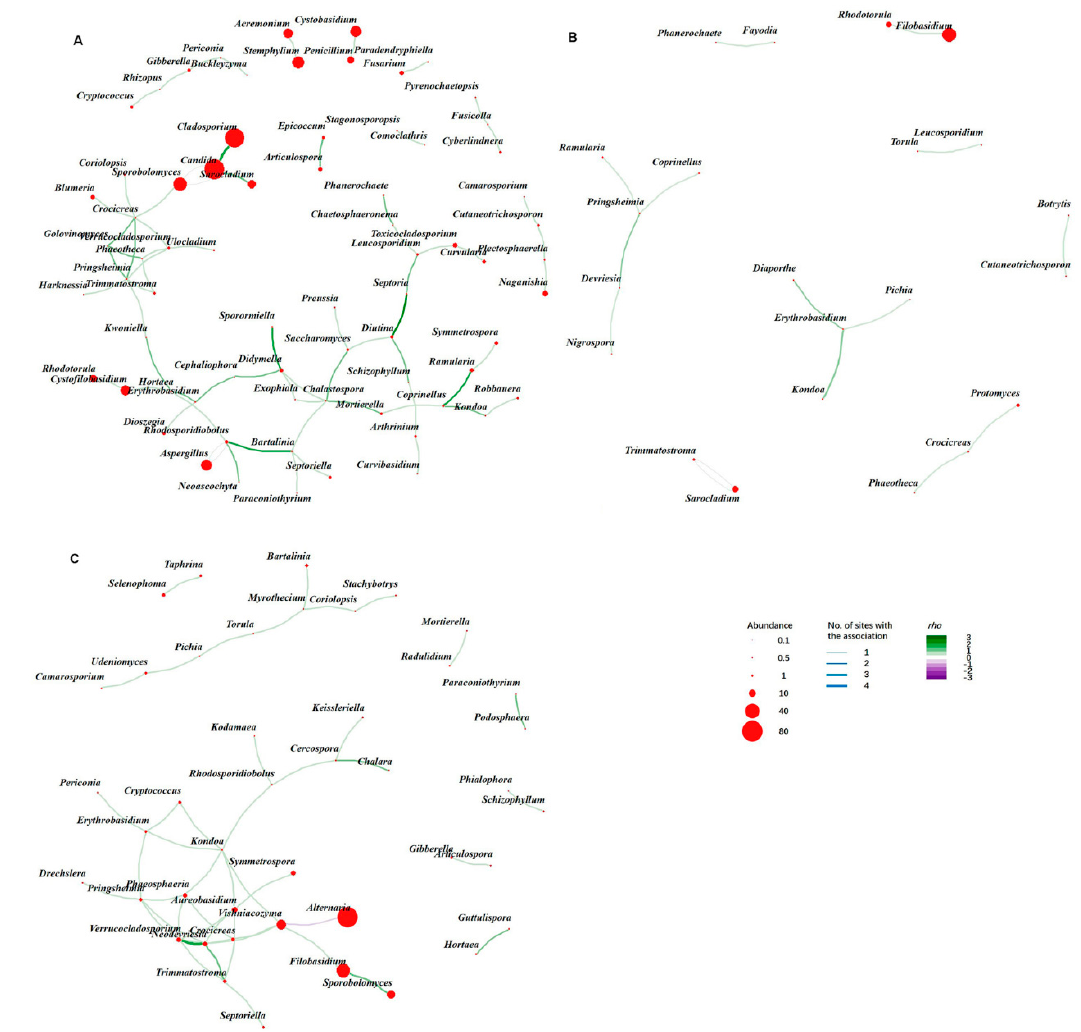
Figure 7. Combined co-occurrence network of FECs in di ff erent host species. The combined network includes co-occurrence associations (edges) with statistical significance ( p < 0.001) presented in no less than two sites in T. aestivum —TA ( A ), T. dicoccoides —TD ( B ), and Ae. sharonensis —AS ( C ). Thicker edges indicate presence of the association in higher number of sites, deeper color indicates higher positive rho (green) or lower negative rho (purple) for the association.